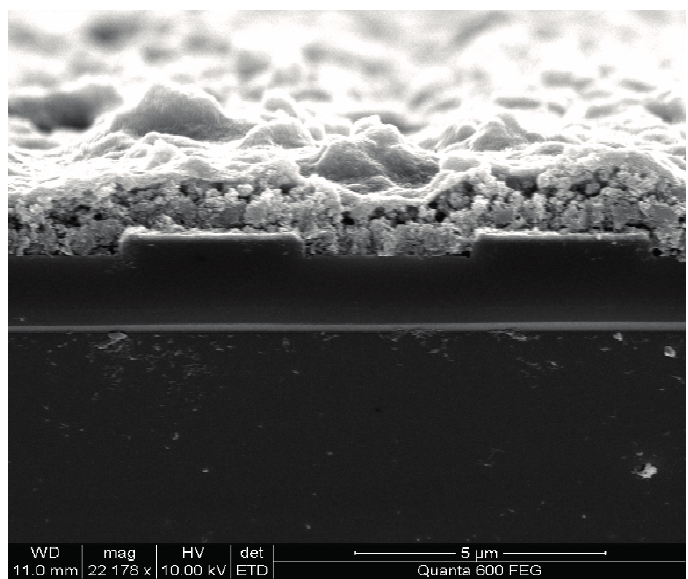
Figure 5. SEM of Cu(bdc)·xH 2 O film.